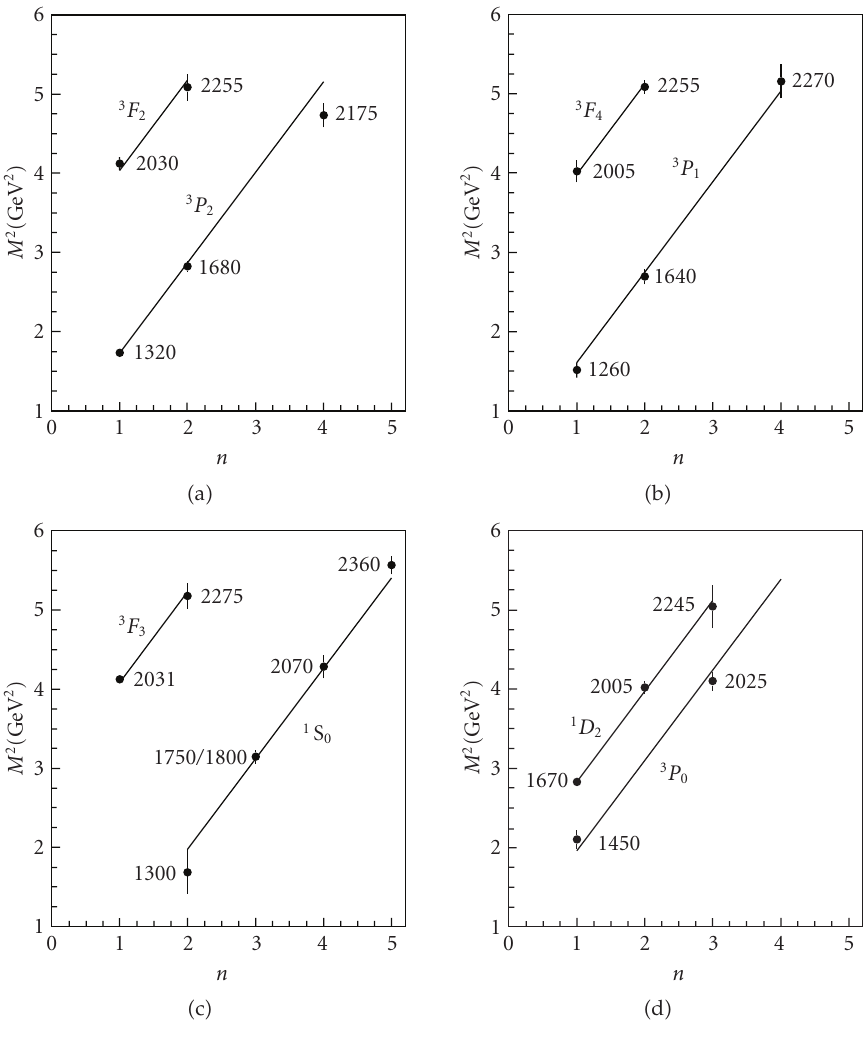
Figure 2: Trajectories of I (cid:12) 1, C (cid:12) (cid:5) 1 states (cid:7) 14 (cid:8)